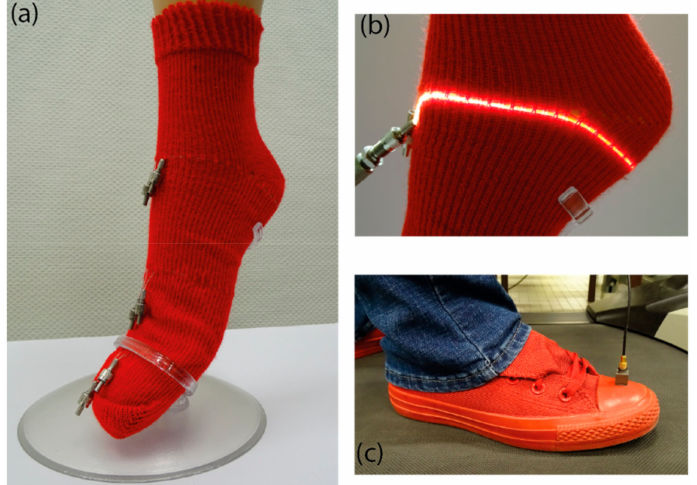
Figure 17. ( a ) Picture of the knitted sock with the three optical fibers; ( b ) magnification of the optical fiber at the heel position; ( c ) setting up the accelerometer.